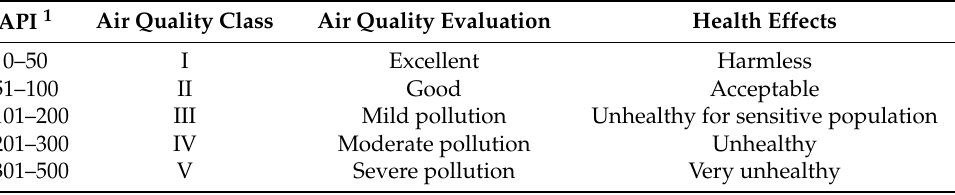
Table 1. Statistical characteristics of Air pollution index (API) in China.